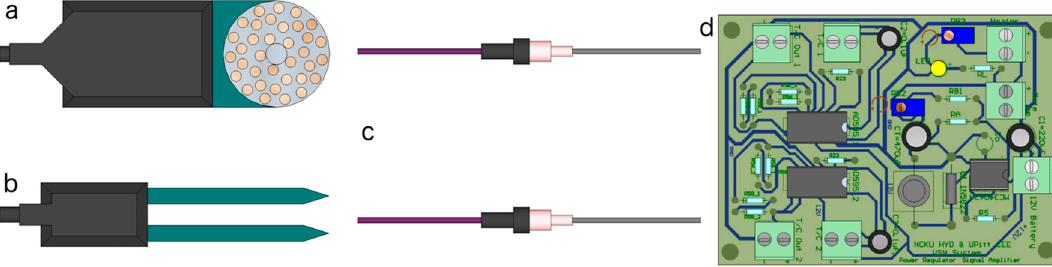
Figure 1. Schematics of the environmental sensors deployed at the ASWP network, including the ( a ) Decagon Devices MPS-1/MPS-2 water potential (WP) sensor; ( b ) Decagon Devices EC-5 soil moisture (SM) sensor; ( c ) thermometric sap flow sensor probes; and ( d ) sap flow sensor circuit.